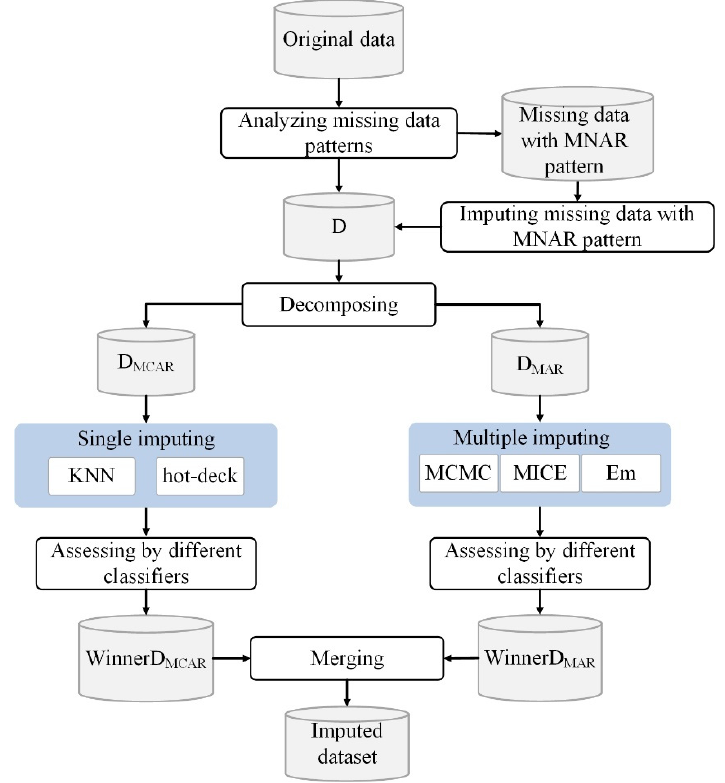
Figure 2. The proposed HIMP method.